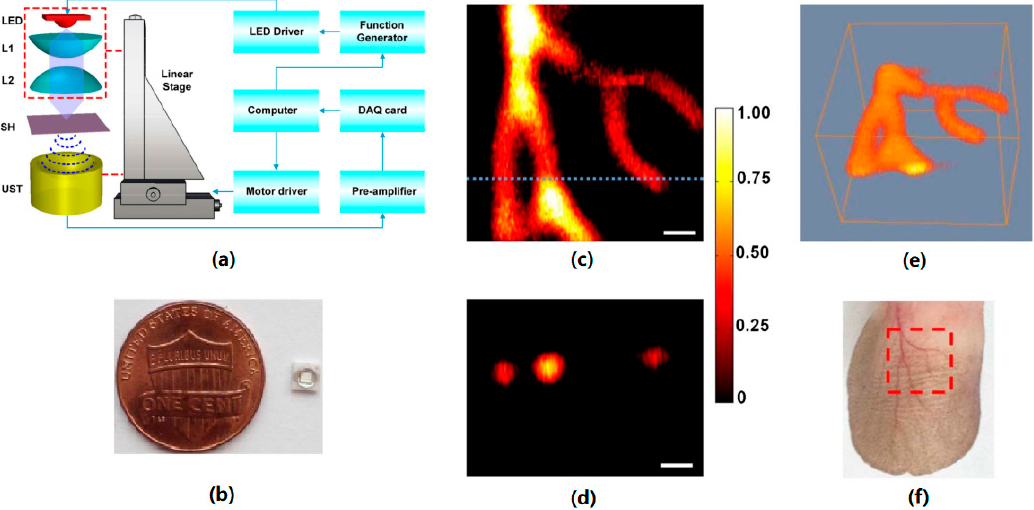
Figure 8. In vivo photoacoustic imaging of mouse ear vasculature. ( a ) LED-PAM system. L1, L2. Lens; SH, sample holder; UST, ultrasound transducer. ( b ) Photograph of LED. ( c ) Maximum amplitude projection (MAP) image. ( d ) Cross-sectional imaging. ( e ) 3D volumetric image. ( f ) Photograph of mouse ear. All the scale bars indicate 0.5 mm in length. Reproduced with permission from Ref. [60].